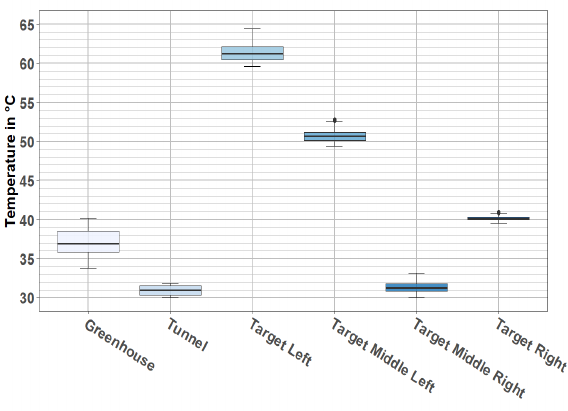
Figure 6. Description of static scenarios.